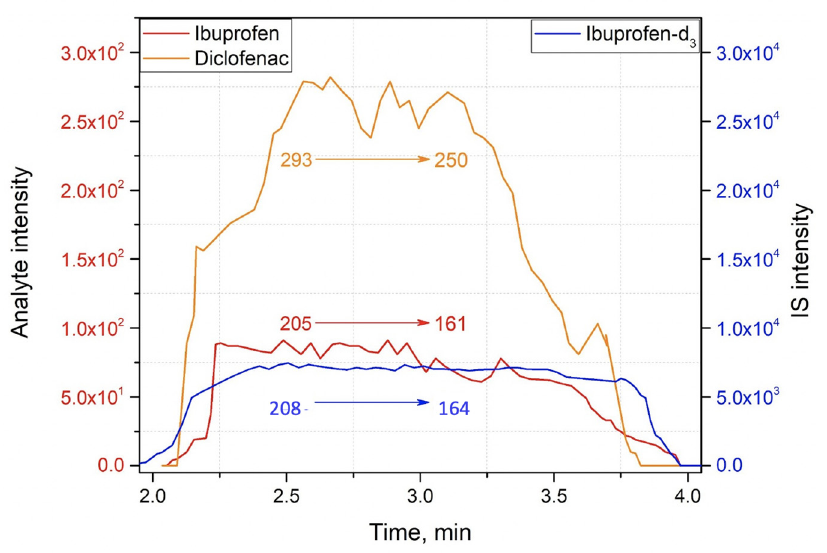
Figure 8. EICs obtained for ibuprofen (2000 ng/mL), diclofenac (2000 ng/mL) and internal standard ibuprofen- d 3 (100 µ g/mL) in negative ion mode for determination of LOD.